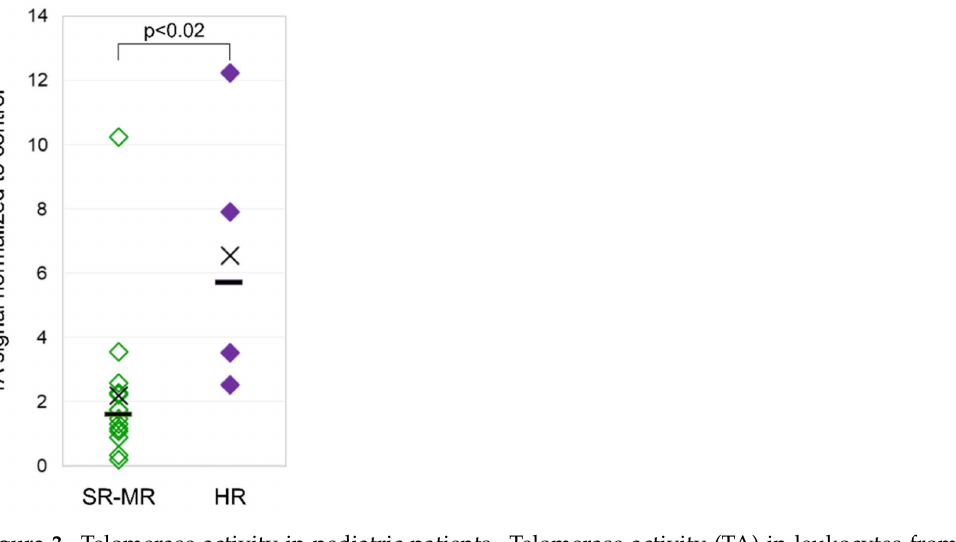
Figure 3. Telomerase activity in pediatric patients. Telomerase activity (TA) in leukocytes from pediatric ALL patients with high risk (right column) compared to patients with standard and medium risk (left column) at diagnosis.